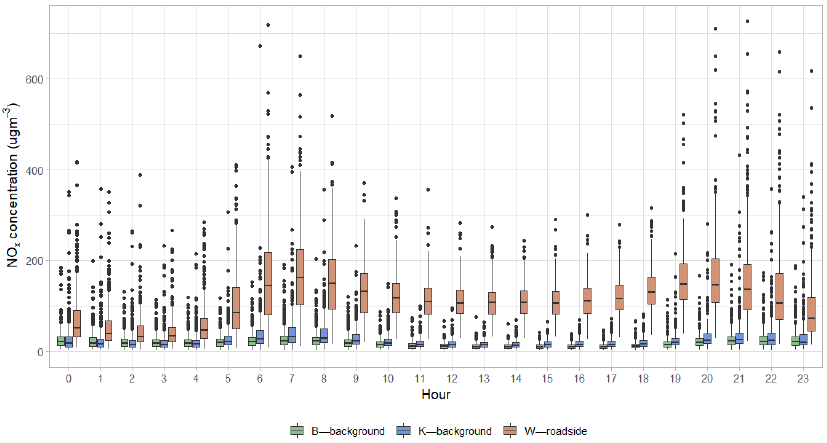
Figure 4. Nitrogen oxide hourly variability from 10 March to 30 May 2016–2019.